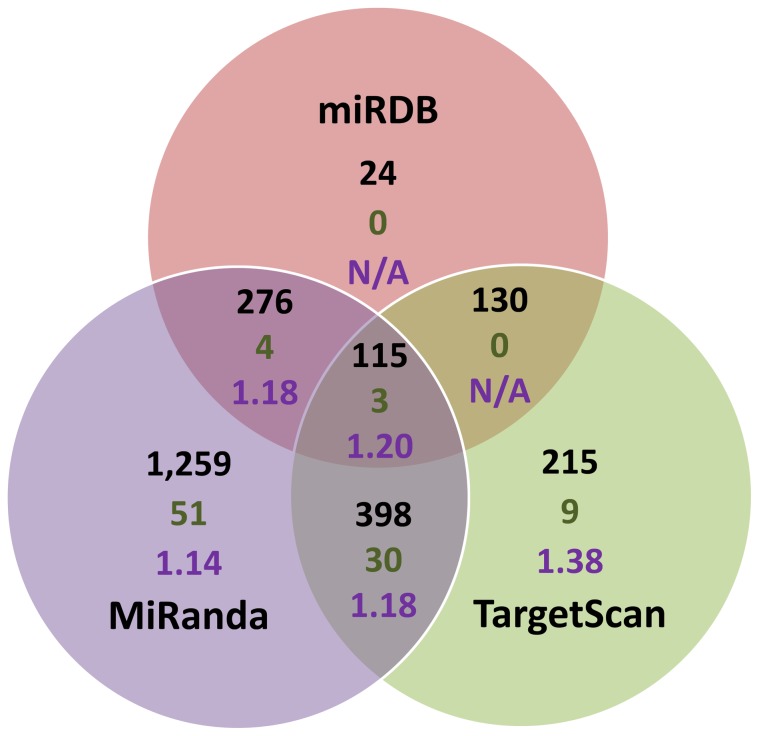
Results for the T2D association signal enrichment analysis in miRNA target gene sets.The Venn diagram represents the sets of miRNA target genes for each miRNA as predicted by miRDB, miRanda and TargetScan alone, or overlap of these methods. Annotated are the median number of genes in each set (black text), the number of significantly (p-value <0.001, q-value <0.1) enriched gene sets (green text), and the median enrichment of the significantly enriched gene sets (purple text).